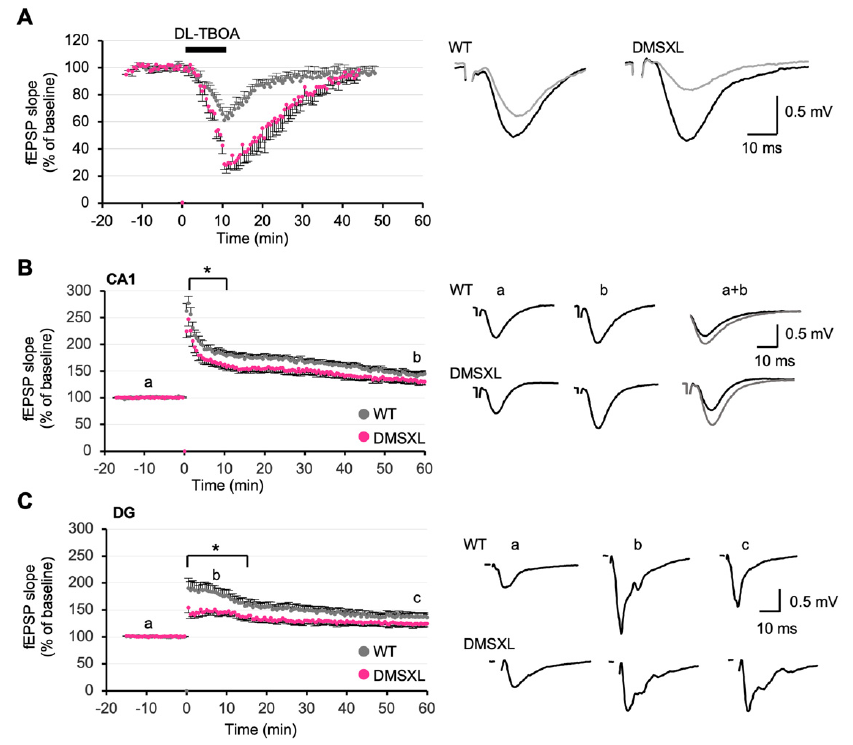
Figure 5. Long-term synaptic plasticity in the DMSXL hippocampus. ( A ) Effects of the inhibitor of glutamate transporter DL-TBOA on fEPSPs. DL-TBOA, applied for 10 min at 40 µM, induced a strong depression of the synaptic transmission in DG of both DMSXL ( n = 4 mice, n = 8 slices) and WT mice ( n = 5 mice; n = 9 slices). The effect was significantly stronger in DMSXL mice, ** p = 0.002. Right, sample traces of recordings before (black) and 20 min after TBOA application (grey) are shown. ( B ) LTP in CA1. The time course of LTP following a 3 × 100 Hz stimulation was significantly decreased in hippocampal slices from DMSXL mice ( n = 9 mice; n = 19 slices) as compared with WT controls ( n = 9 mice; n = 19 slices), * p = 0.022. The potentiation measured 60 min after stimulation was not different between genotypes, p = 0.1. Examples of fEPSP recordings during the baseline (a) and 60 min after induction of LTP (b) are shown on the right. ( C ) LTP in DG. LTP induced by a 2 × 100 Hz stimulus was significantly decreased in DMSXL mice ( n = 7 mice; n = 12 slices) during the early phase postinduction (first 15 min following stimulation) compared with WT ( n = 6 mice; n = 15 slices). * p = 0.019. The mean LTP magnitude during the last 15 min of the recordings was comparable between genotypes, p = 0.17. The overall time course of LTP was significantly different in DMSXL mice, * p = 0.047. On the right, individual traces of fEPSPs are shown in the three conditions: before (a), 10 min after stimulation (b), and 60 min after stimulation